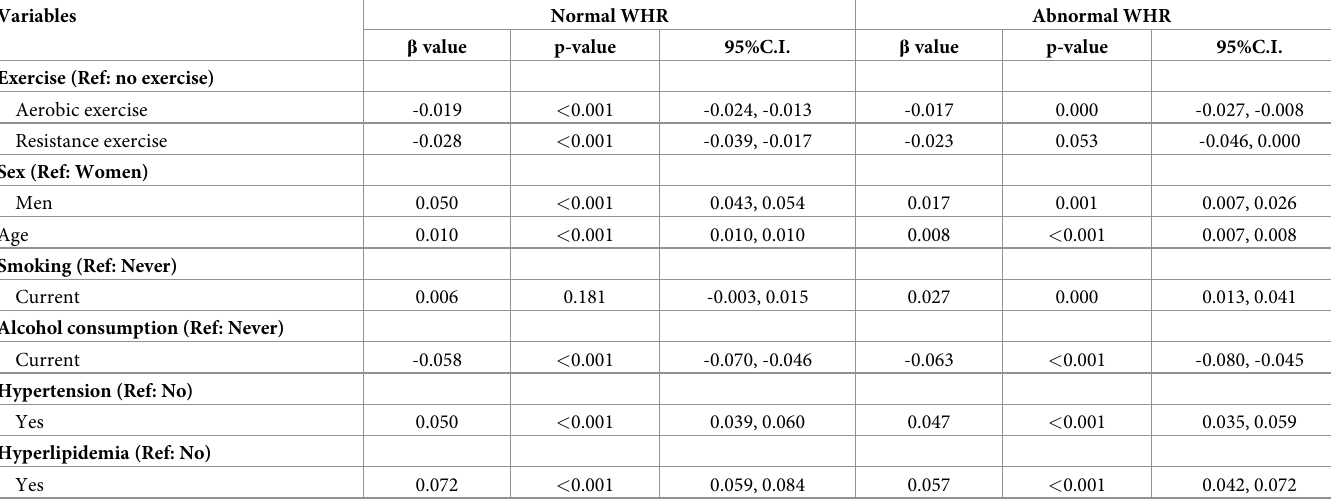
Table 3. Multiple linear regression showing association of HbA1c with study variables based on